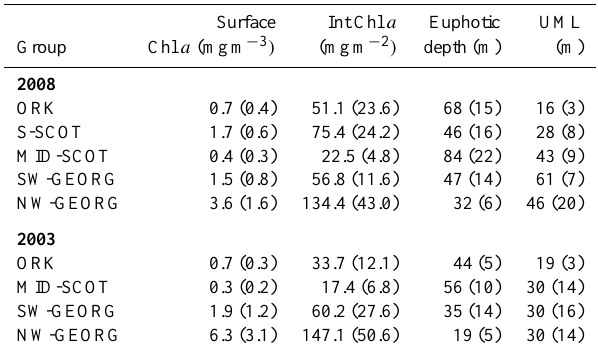
Table 4. Station group averages and standard deviations for surface (20m) and depth integrated Chl a , euphotic depth and mixed layer depth for the 2003 and 2008